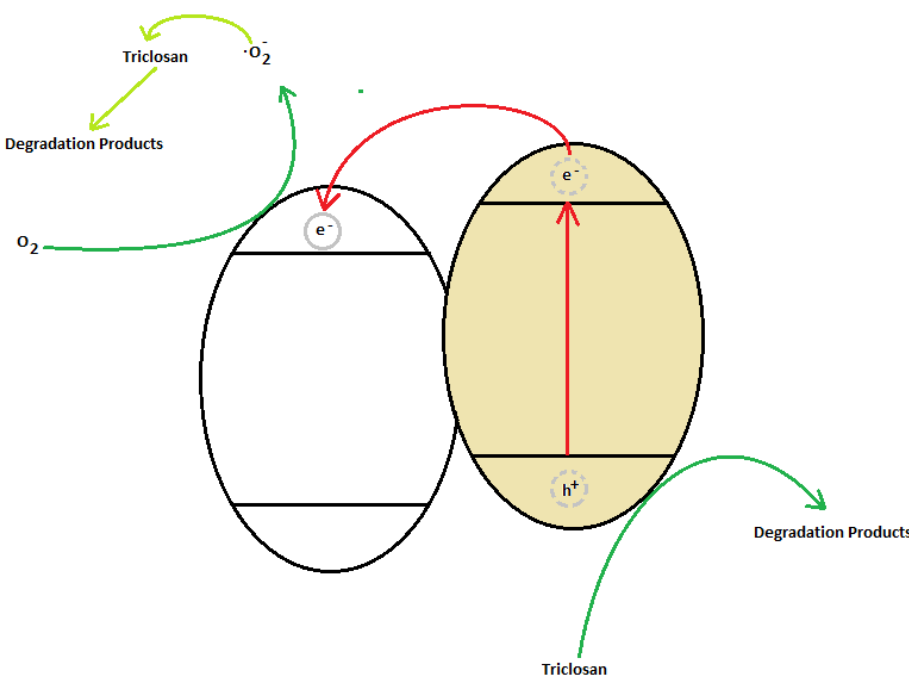
Figure 8. Z-scheme of electron transfer.